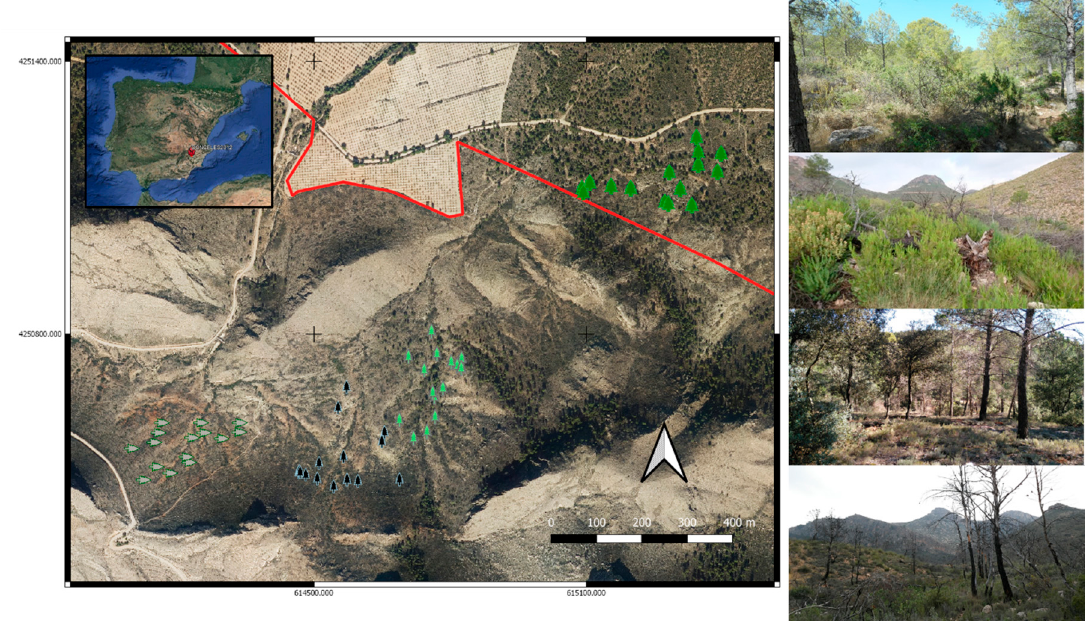
Figure 1. Location of the wildfire in the southeastern Iberian Peninsula (almost 6500 ha burned in the summer of 2012). Plots sampled in June 2017 were set in unburned natural Aleppo pine stands (UB; dark greenish ‐ pine tree icon), low ‐ burn severity (LS; light greenish ‐ pine tree icon), high ‐ burn severity unmanaged (HS; blackish ‐ pine tree icon), and high ‐ burn severity with post ‐ fire salvage logging (HSSL; greenish ‐ fallen pine tree icon).